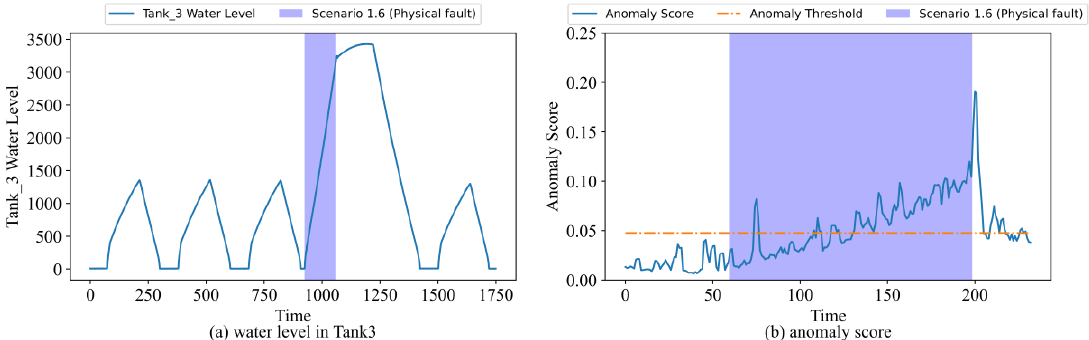
Figure 7. Anomaly scores for the proposed model (using cyber – physical features).